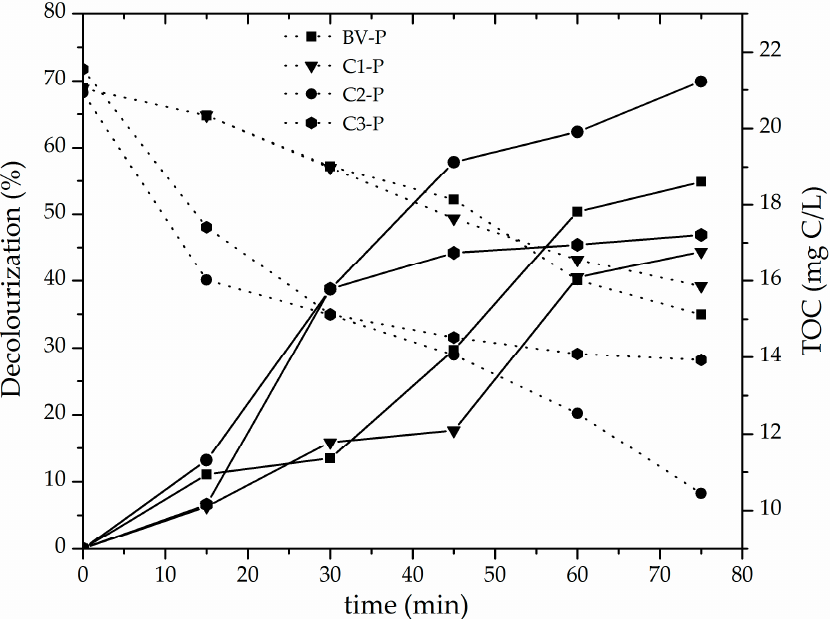
Figure 7. Catalytic behavior of pillared clays in terms of methyl orange decolourization (solid lines) and TOC concentration (dotted lines): Catalyst loading = 0.05 g/L; [MO] 0 = 0.119 mmol/L; [H 2 O 2 ] added = 51.2 mmol/L, V added = 100 mL; H 2 O 2 stepwise addition = 100 mL/h; pH = 3.4; T = 25 ± 0.1 °C; ambient pressure = 0.76 atm.